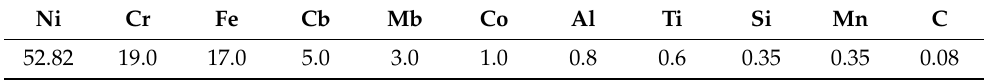
Table 1. Inconel 718 chemical composition